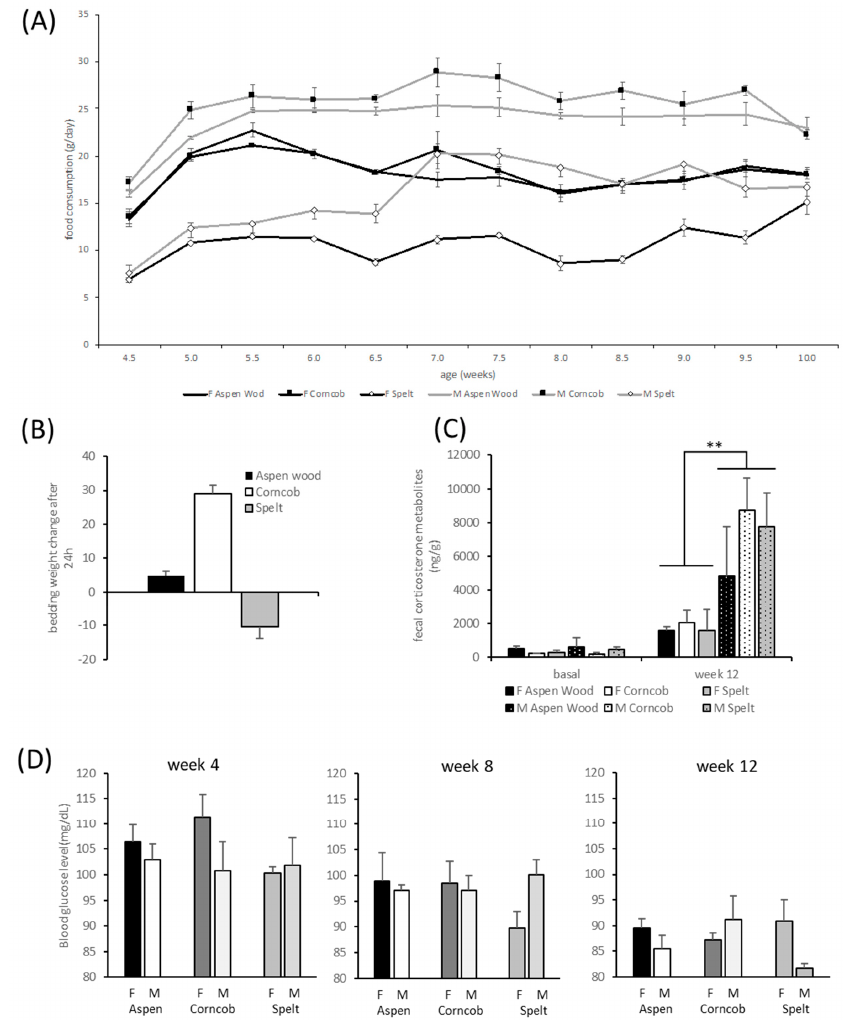
Figure 3. Food consumption, bedding usage, fecal corticosterone metabolites, and blood glucose levels of rats kept on one type of bedding. ( A ) Consumption of food pellets over a period of 8 weeks in males and females varies with the two lower curves representing feeding behavior in males and females housed on spelt bedding; ( B ) aspen wood chip and corncob bedding weight increased after usage, while spelt weight/quantity is reduced after housing rats for 24 h (**); ( C ) Fecal corticosterone metabolites do not differ significantly concerning bedding substrate but are dependent on sex, although this effect is not present at an age of 4 weeks (basally) but is present at an age of 12 weeks; ( D ) Blood glucose levels in males and females, as assessed during Weeks 4, 8, and 12, are reduced over time with varying directions depending on ‘sex’, ‘time’, and ‘bedding’.